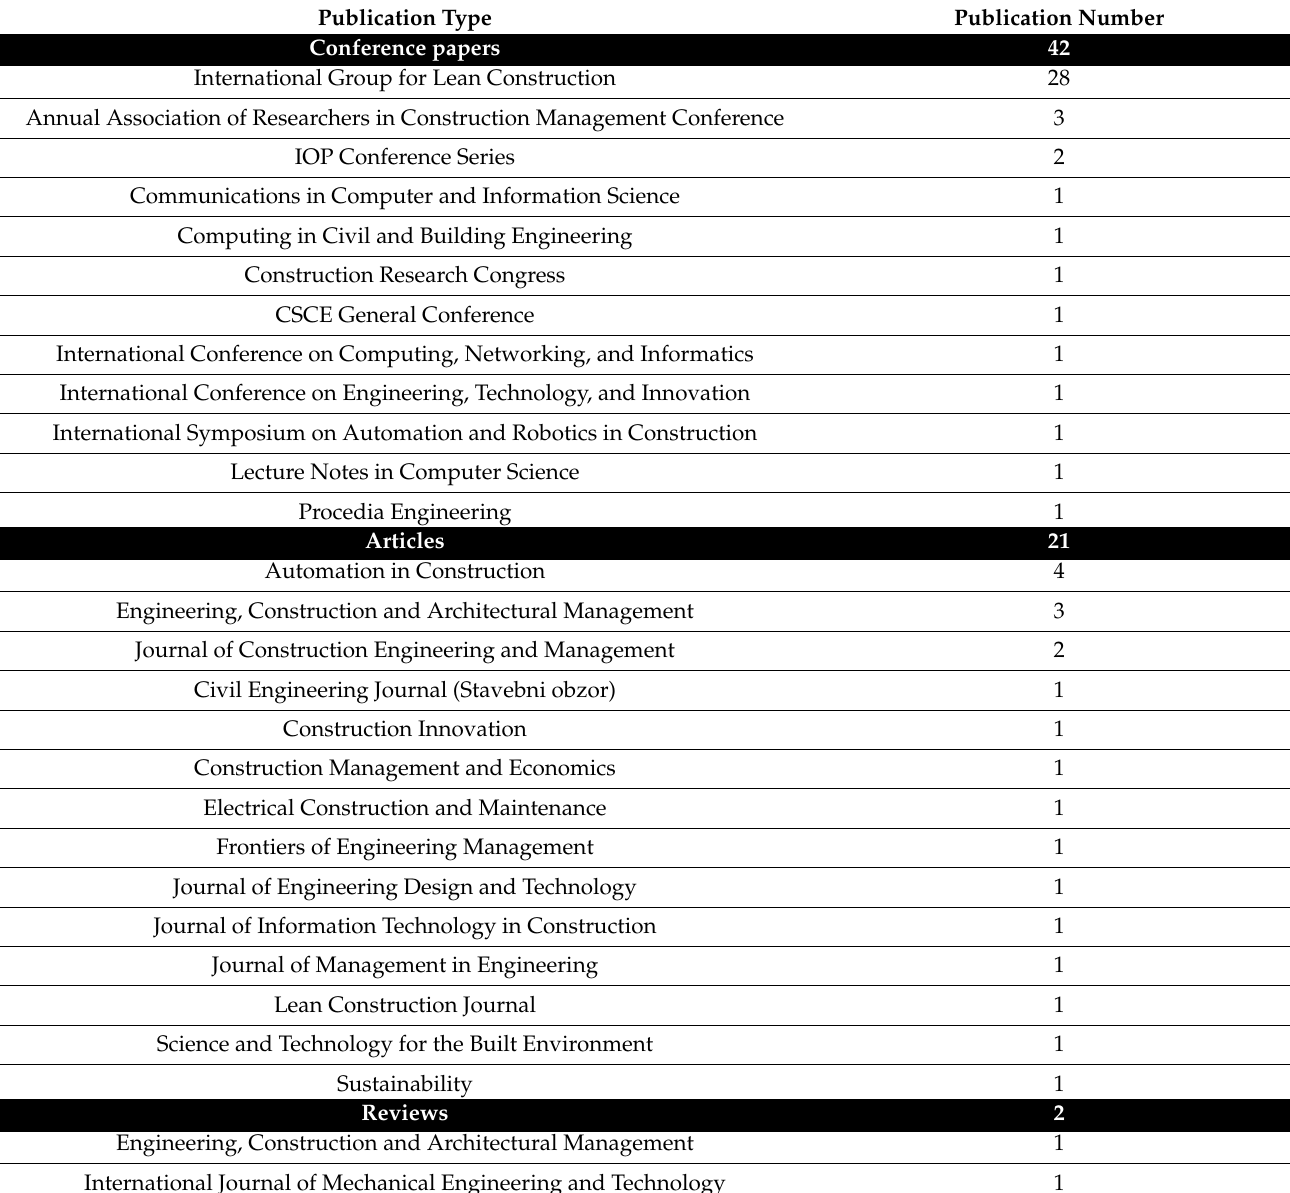
Table 2. Reviewed publication